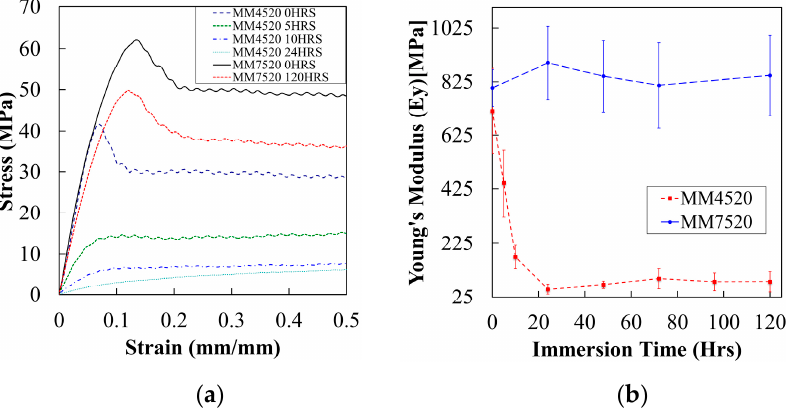
Figure 9. Graphs showing the mechanical behavior of both materials. ( a ) Describes the evolution in mechanical behavior while ( b ) shows the drop in elastic modulus with respect to immersion time in water.